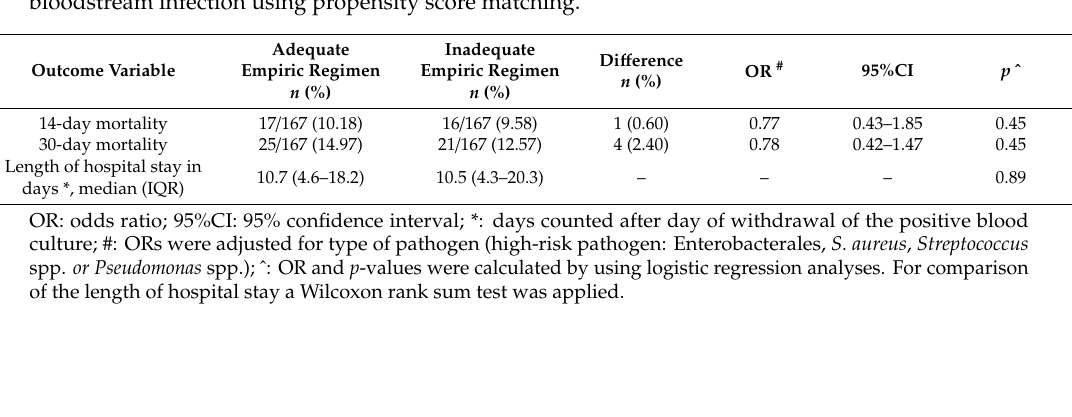
Figure 1. Standardized di ff erences of study variables before- and after propensity score matching. An * indicates that the variable was included in the propensity score model. The shaded area represents the distribution with a standardized di ff erence (SDD) < 10. MDRO = Multidrug-resistant pathogen. TTP = time to positivity. ICU = intensive care unit. Fever was defined as temperature > 38.5 ◦ C. Neutropenia: absolute neutrophil count < 0.5 × 10 9 / mL. Table 2. Outcomes after adequate and inadequate empiric antimicrobial therapy in patients with bloodstream infection using propensity score